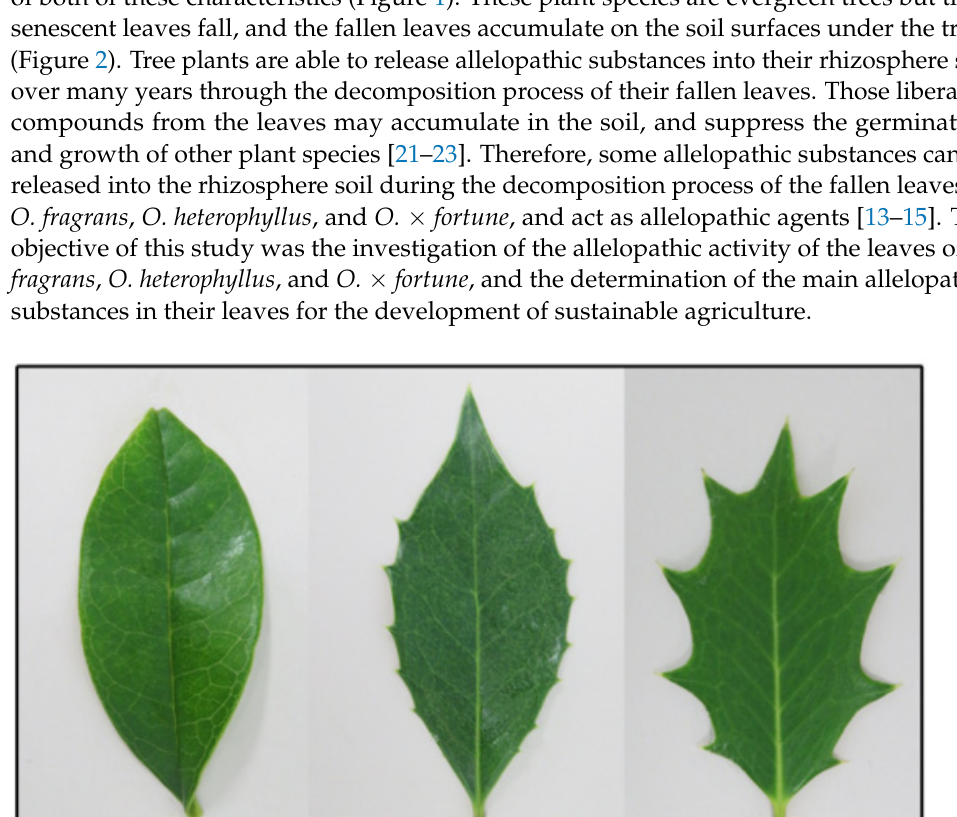
Figure 2. The accumulation of the fallen leaves on the soil under the tree of O. × fortune .